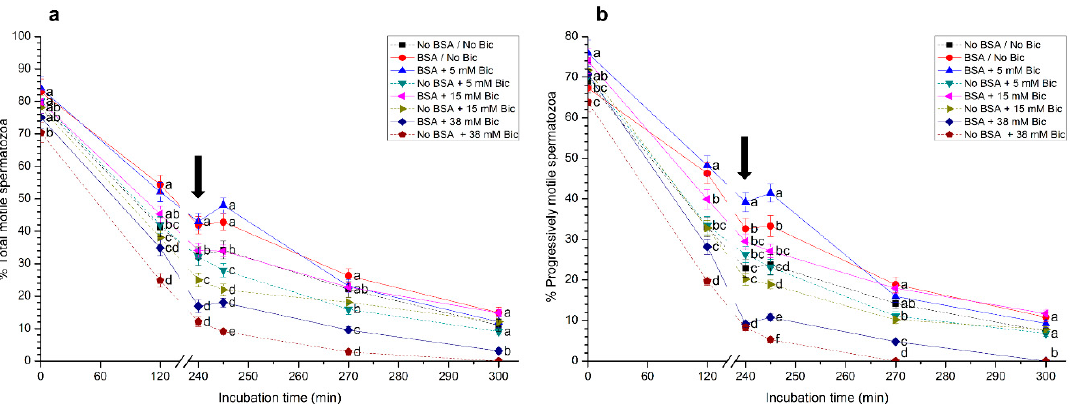
Figure 6. ( a ) Percentages of total and ( b ) progressively motile sperm following incubation with different concentrations of bicarbonate (Bic; 0 mM, 5 mM, 15 mM, 38 mM) and BSA (0, 5 mg/mL) for 300 min. The black arrow indicates the time at which 10 µ g/mL of progesterone was added (i.e., 240 min) to induce acrosome exocytosis. Different superscripts (a–f) indicate significant differences ( p < 0.05) between treatments within the same time point. Data are shown as mean ± SEM for 12 independent experiments.